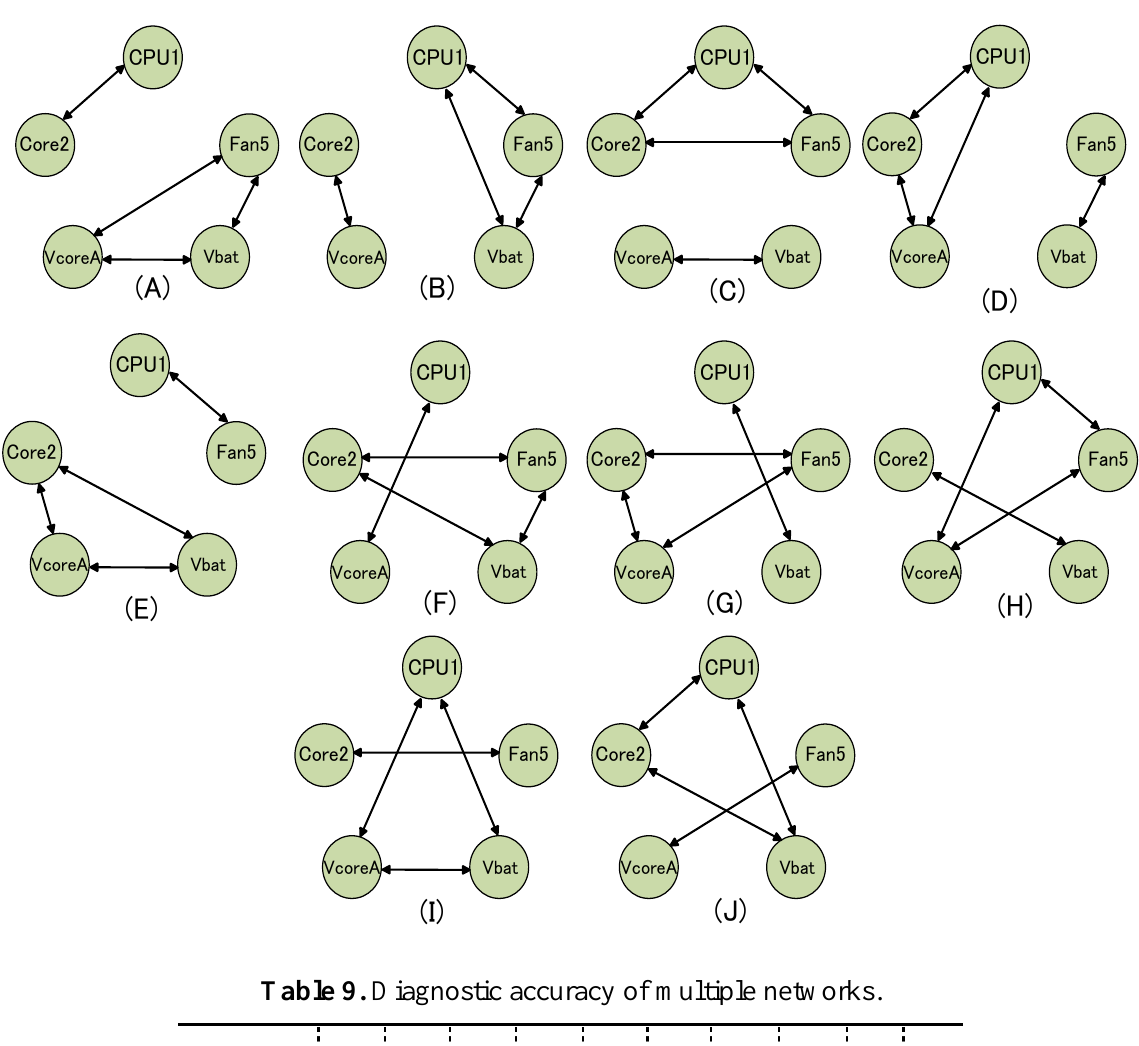
Figure 5. Multiple diagnostic networks.